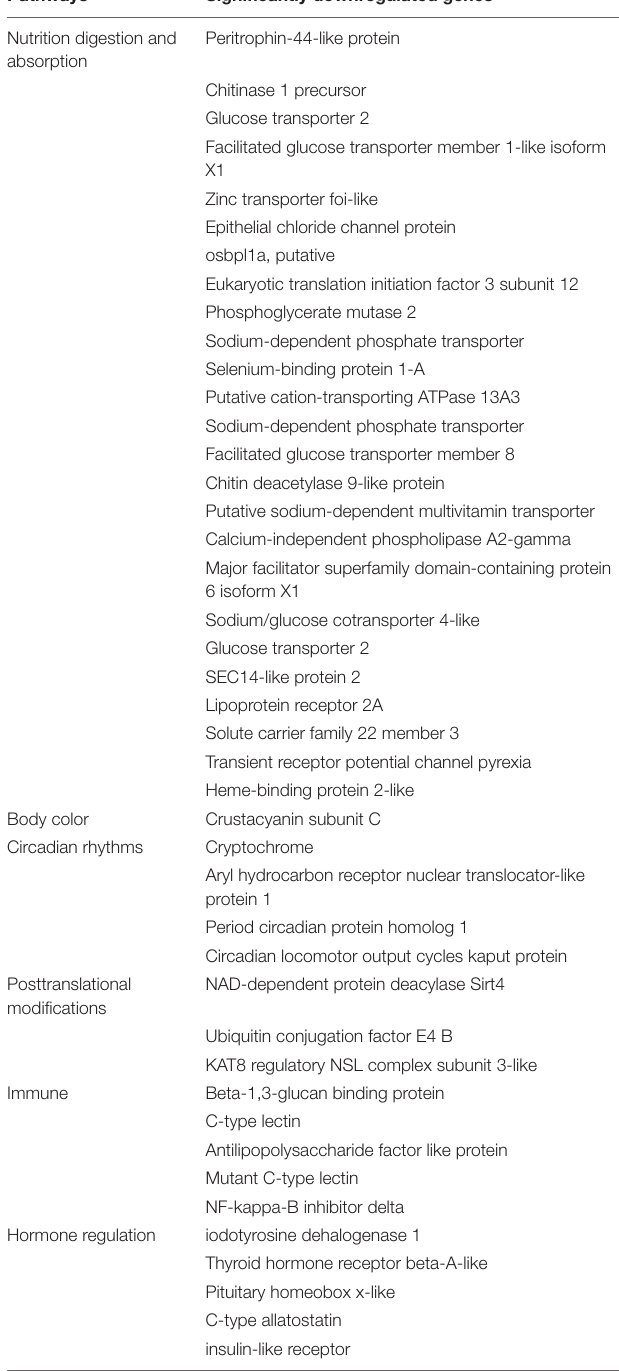
TABLE 2 | Summary of significantly downregulated